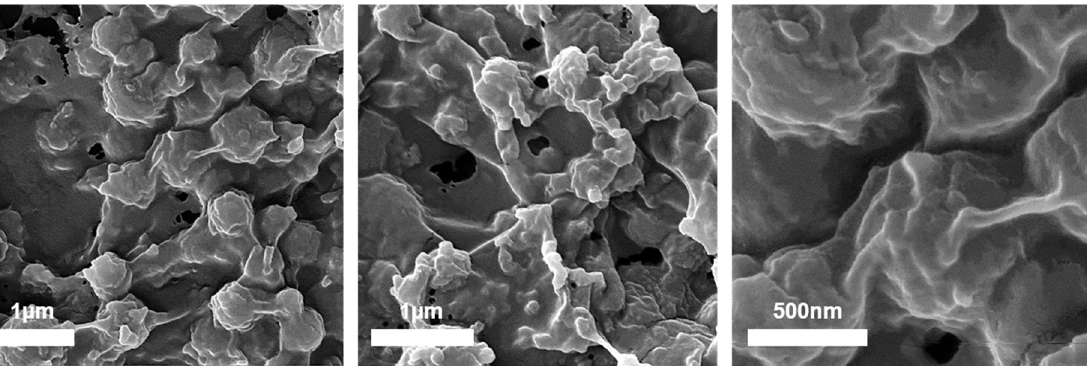
Figure 10. HRSEM images of MWCNT/PANI conjugates at a ratio of 1:1 doped with Ag + embedded into PVC poly acrylate at a ratio of 1:10.